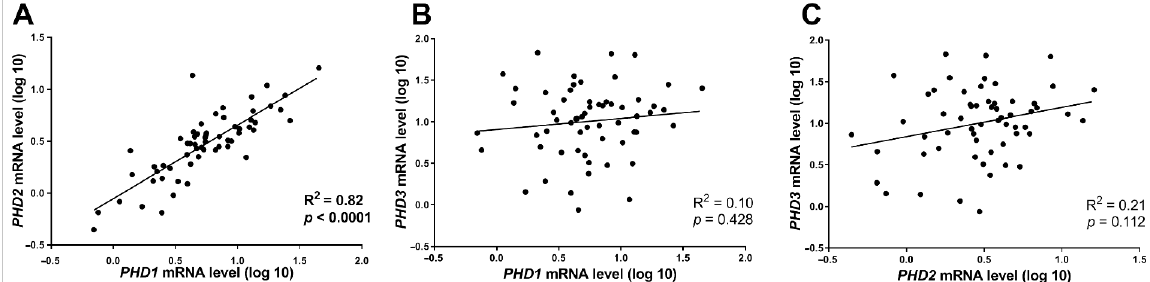
Figure 2. Spearman’s rank correlation coefficient analysis of associations between PHD1 , PHD2 and PHD3 mRNA expression levels in 60 primary lung tumour samples. Linear regression results between ( A ) PHD1 and PHD2 , ( B ) PHD1 and PHD3 and ( C ) PHD2 and PHD3 mRNA levels.